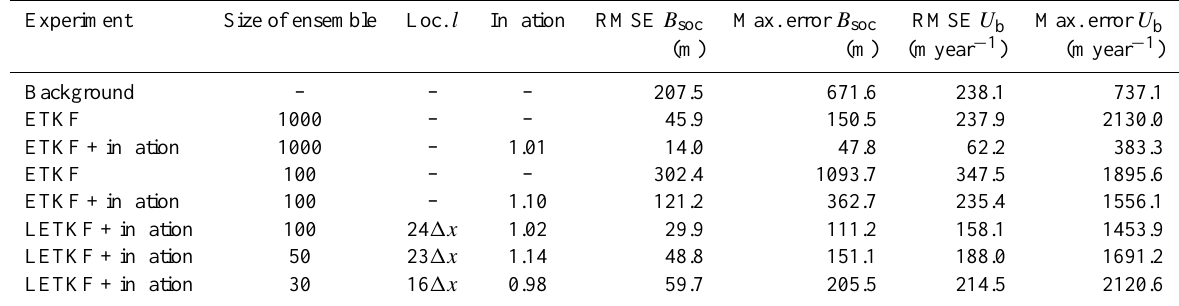
Table 3. Summary of best LETKF+inflation results in term of RMS and maximal absolute difference and comparison with standard ETKF